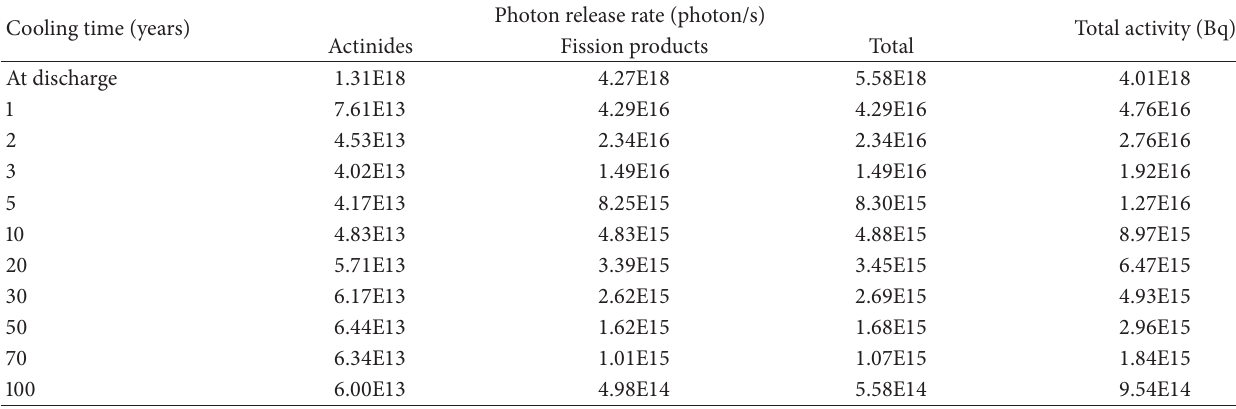
Table 3: Photon release rate and total activity of the BNPP SFA (49GWd/MTHM).